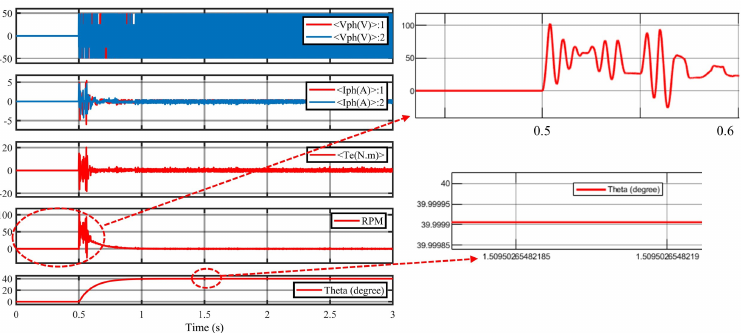
Figure 13. The outputs of stepper motor in the EWB system based on the PID